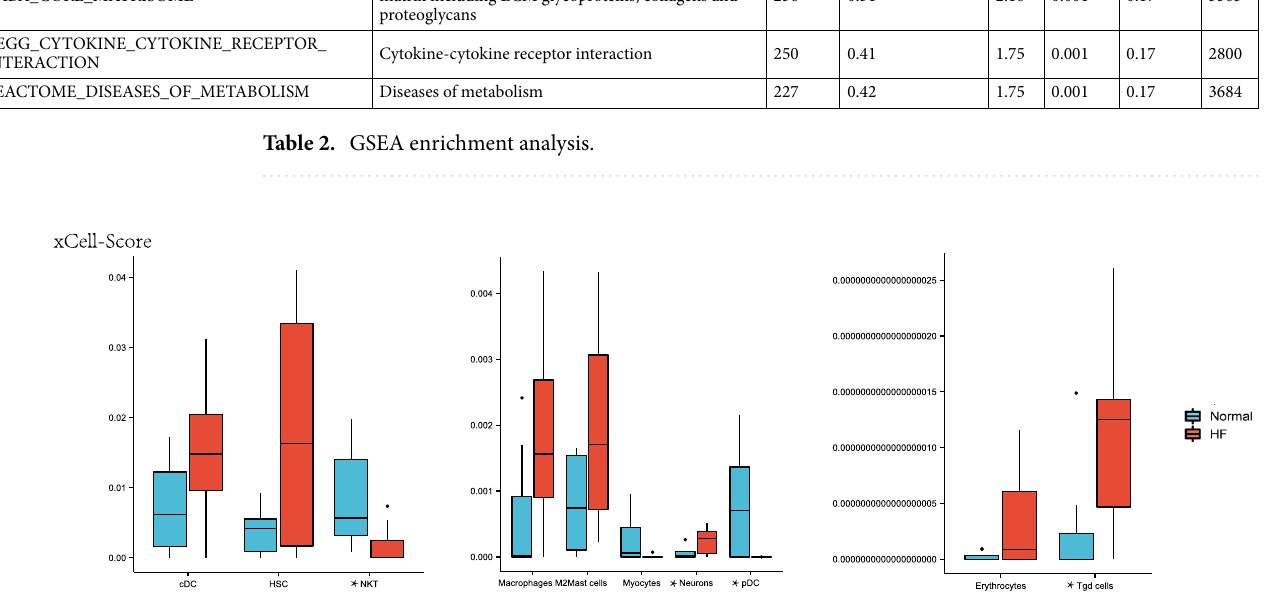
Figure 5. xCell scores of immune and stromal cells between HF and healthy heart tissues in merged dataset (* p < 0.05; Normal: Normal Group; HF: Heart Failure Group).